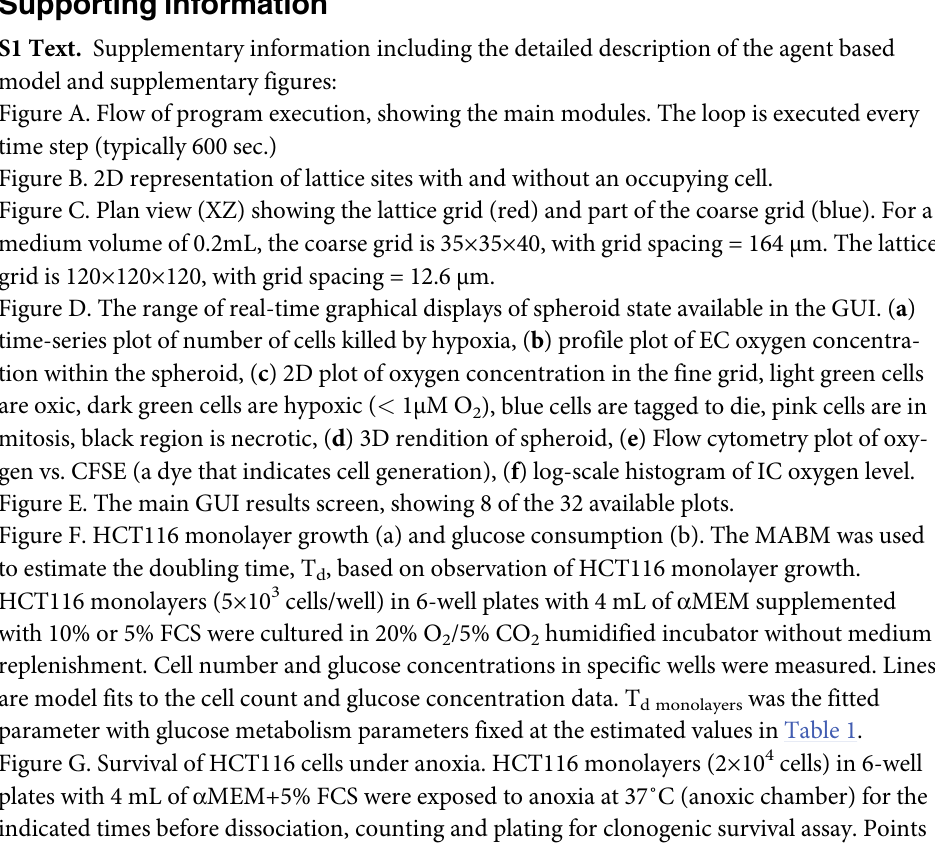
Figure G. Survival of HCT116 cells under anoxia. HCT116 monolayers (2 × 10 4 cells) in 6-well plates with 4 mL of α MEM+5% FCS were exposed to anoxia at 37˚C (anoxic chamber) for the indicated times before dissociation, counting and plating for clonogenic survival assay.